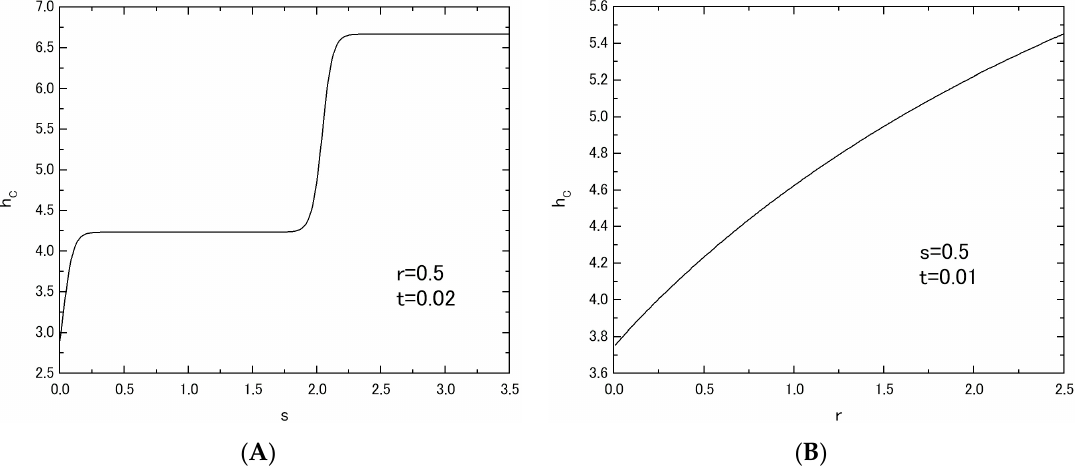
Figure 6. The variations of h C in the system B; the variation of h C in the system with r = 0 . 5 and t = 0 . 02 is given, when the value of s is changed from s = 0 . 0 to s = 3 . 5 ( A ). The variation of h C in the system with s = 0 . 5 and t = 0 . 01 is given, when the value of r is changed from r = 0 . 0 to r = 2 . 5 ( B ).